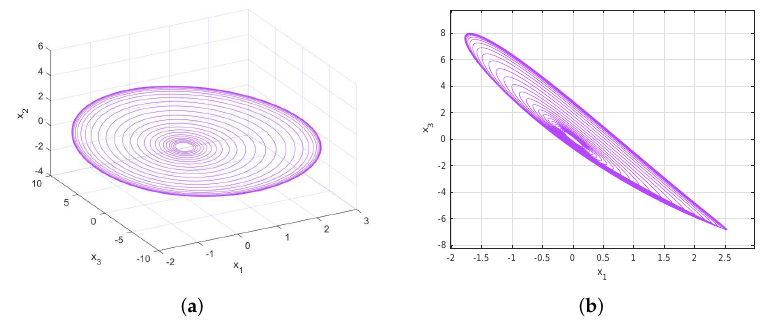
Figure 1. Phase portraits of: ( a ) Chaotic attractors on x 1 − x 2 − x 3 ; ( b ) Projection of chaotic attractors on x 1 − x 3 .